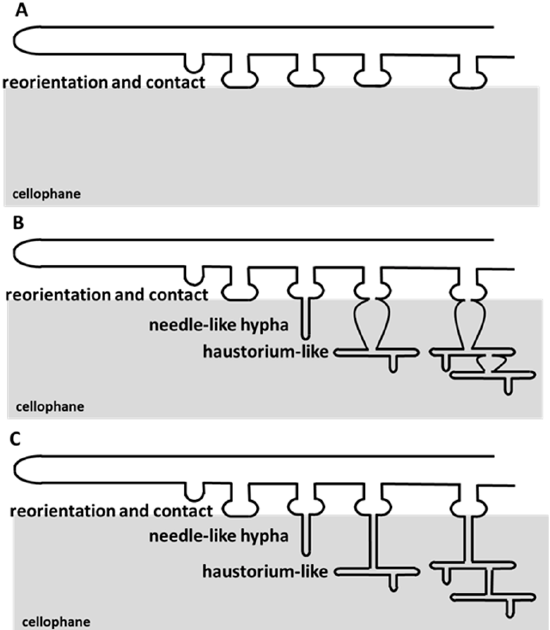
Figure 4. Schematic of appressorial development. ( A ) The fungi, showing clear tropism towards cellophane, reorient hyphal growth towards cellophane and establish contact points at the cellophane surface. ( B , C ) The fungi, able to penetrate cellophane, develop appressoria in five steps. (i) They reorient hyphal growth, (ii) establish contact points, (iii) emit a penetration peg in order to breach cellophane, and (iv) starthaustorium-like growth inside the cellophane layer. The haustorium-like enlarges with time and it becomes the base for the emission of more penetration pegs. This process allows invasion (v) and eventual breaching of the cellophane layer. In some species, concurrently to their intra-cellophane development, the penetration peg enlarges and becomes hardly distinguishable from other fungal structures inside the cellophane ( B ).